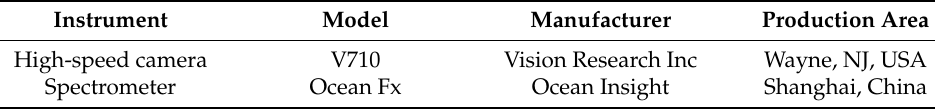
Table 4. Information about the experimental instruments.